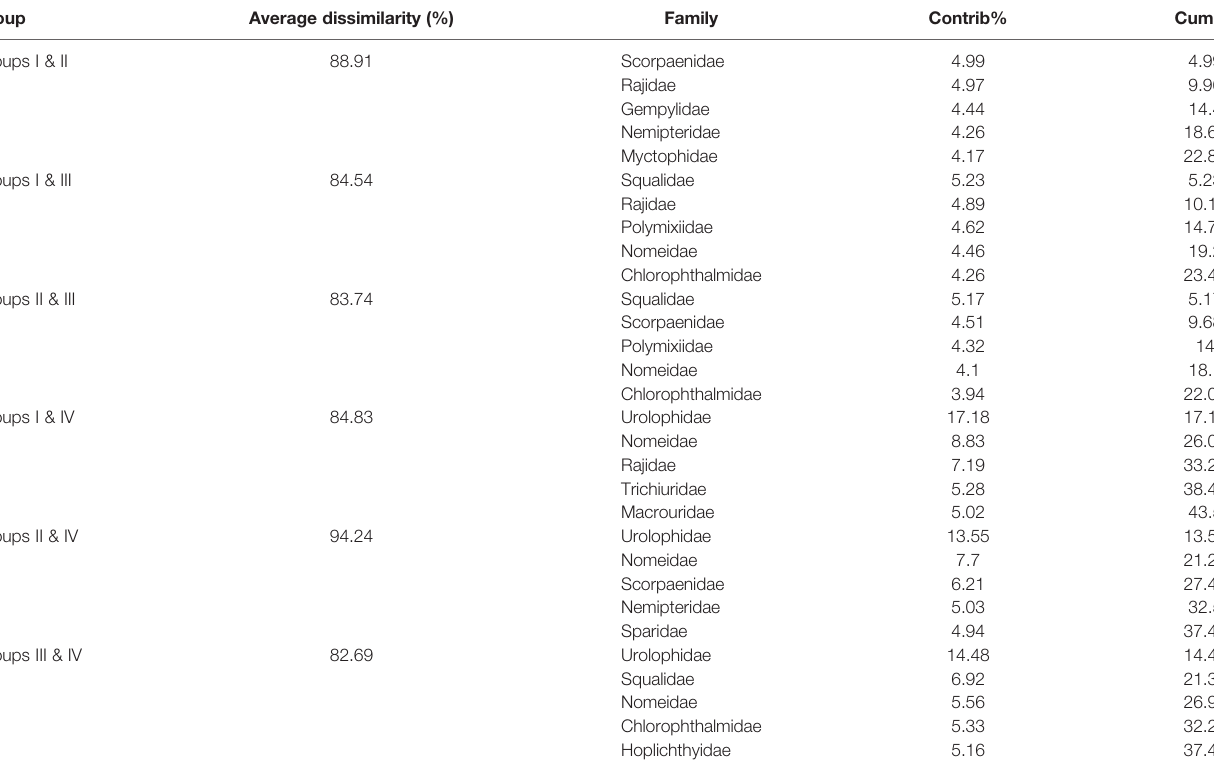
TABLE 7 | Average dissimilarity and top fi ve discriminating families among group I, II, III, and IV over the NCSSCS. Group Average dissimilarity (%) Family Contrib% Cum.% Groups I &